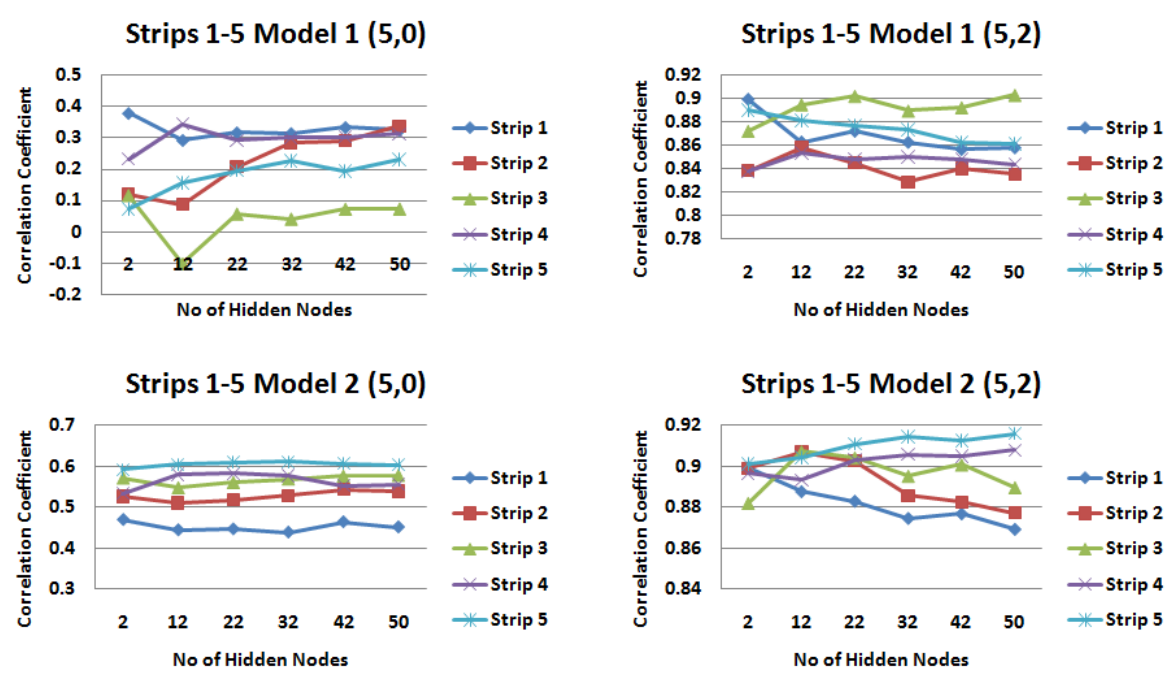
Figure 8. Correlations for input models 1 and 2 for 5 days rainfall information and 0 and 2 days water level information for each strip of the